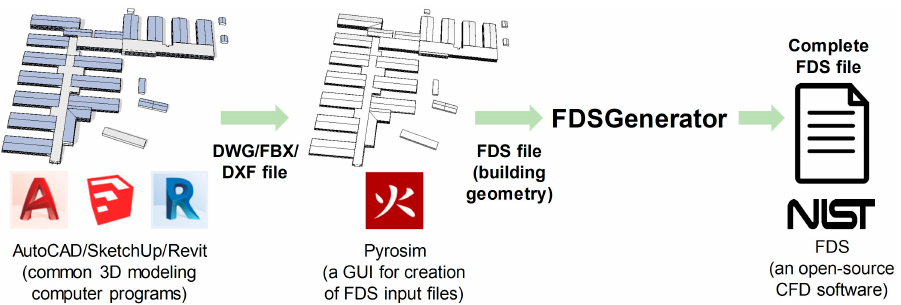
Figure 4. Modeling method of the temporary hospital for FDS based on BIM.